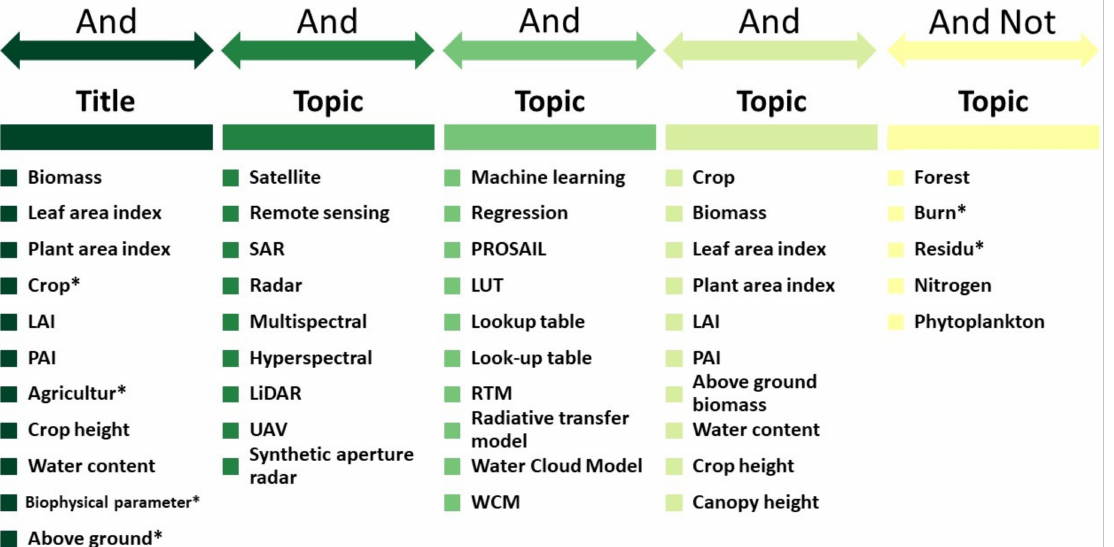
Figure 1. Designed search query and corresponding search phrases for crop parameter estimation review. Key terms in the first column were imported as input data in the topic, and the other columns were in the title. (Leaf area index (LAI), plant area index (PAI), look-up table (LUT), radiative transfer model (RTM), water cloud model (WCM)). The star marks mean that the system identified all suffixes, including the primary